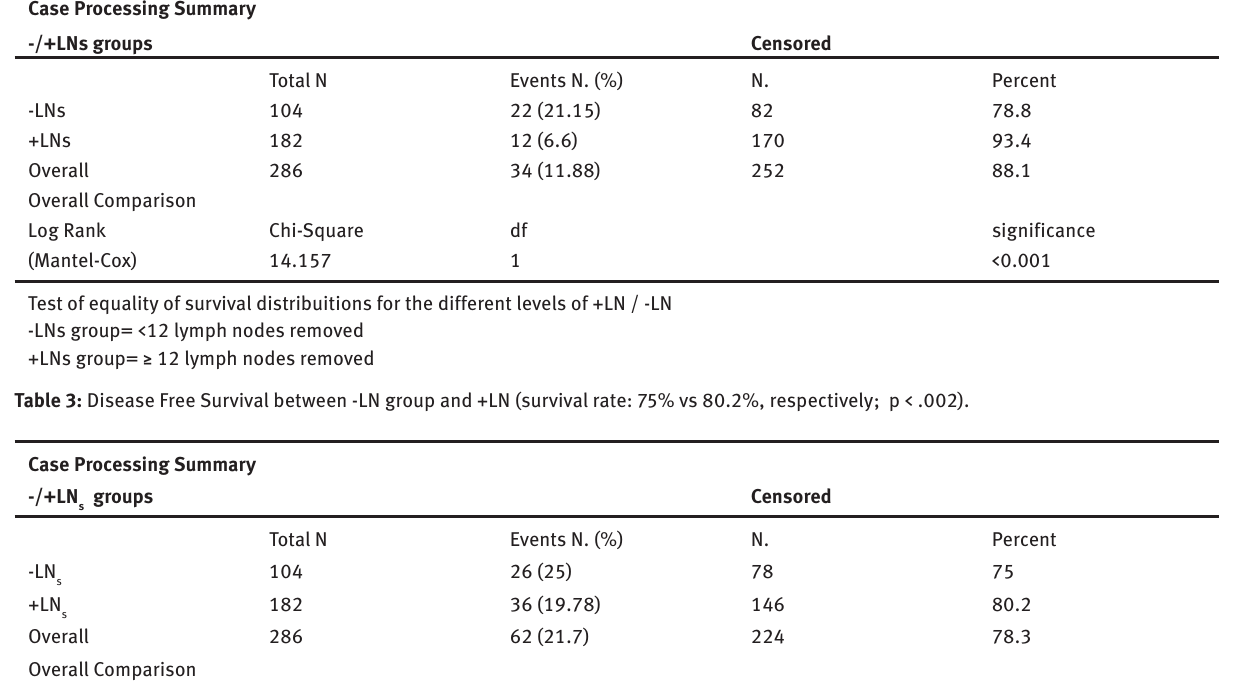
Table 2: Disease Free Survival between -LNs group and +LNs group (relapse rate: 21.15% vs 6.6%, respectively; p < 0.001). Case Processing Summary